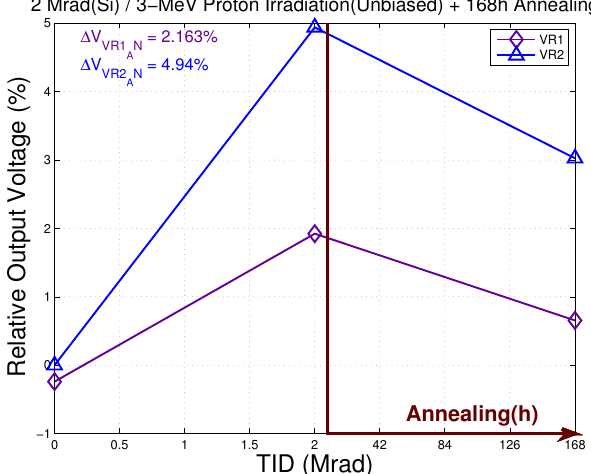
Figure 19. Relative output voltage (%) of the VR1 and VR2 when exposed to protons. The chips were irradiated unbiased with 3 MeV protons in vacuum, up to a fluence of 1.47 × 10 12 p/cm 2 with a flux of 10 9 p/cm 2 · s. This corresponds to a total ionizing dose of 2 Mrad(Si), followed by three days of